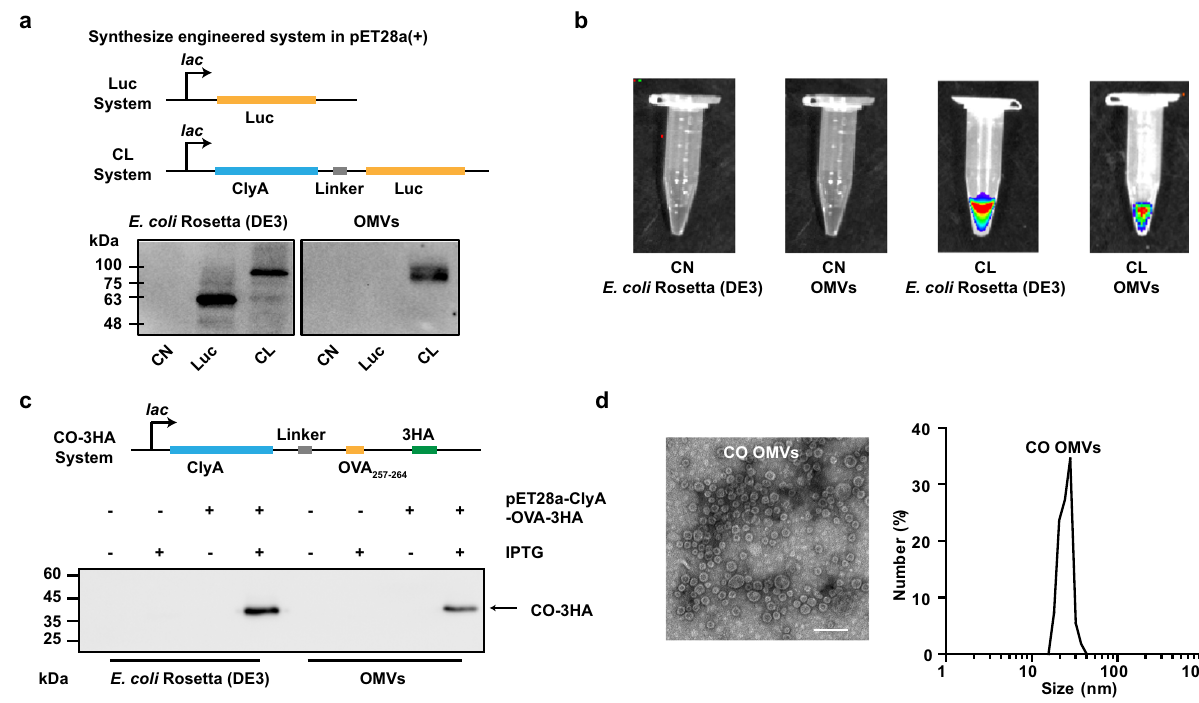
Fig. 1 Engineered display of heterologous proteins or antigen peptides on the OMVs surface. a Schematic representation of the pET28a-Luc and pET28a-ClyA-Luc construct, and western blot analysis of ClyA-none (CN), Luc, and ClyA-Luc (CL) expression in E. coli Rosetta (DE3), and OMVs derived from the bacteria. b In vitro bioluminescence images to demonstrate luciferase enzyme activity following expression in Rosetta (DE3) and OMVs. c Schematic representation of the pET28a-ClyA-OVA-3HA construct, and western blot analysis of 3× HA-tagged ClyA-OVA (ClyA-OVA-3HA, CO-3HA) expression in E. coli Rosetta (DE3) and OMVs. pET28a-ClyA-OVA-3HA was the expression plasmid, and IPTG was the expression inducer. d TEM image and DLS analysis of ClyA-OVA OMVs (CO OMVs). Scale bar, 100 nm. Source data are provided as a Source Data fi